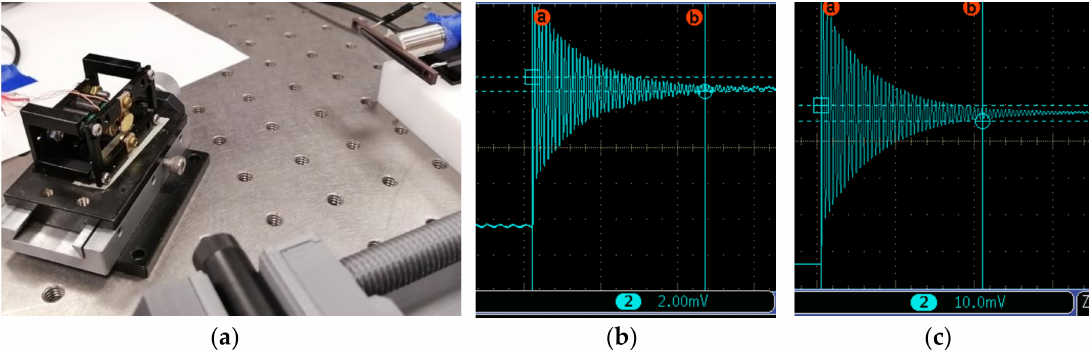
Figure 8. Step response test. ( a ) Step response test setup. ( b ) Step response curve from − 1V to + 1V. ( c ) Step response curve from − 5V to + 5 V.